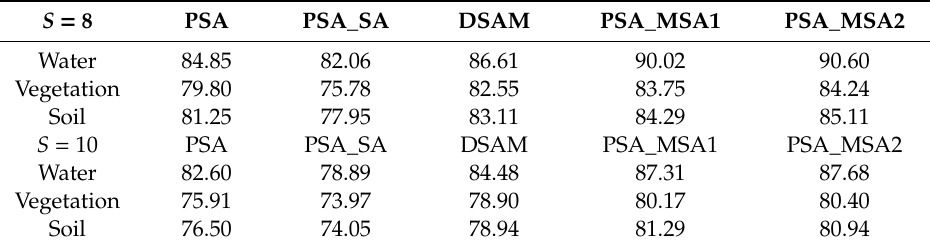
Table 6. Improved PCC (cid:48) values (%) of di ff erent land covers for five